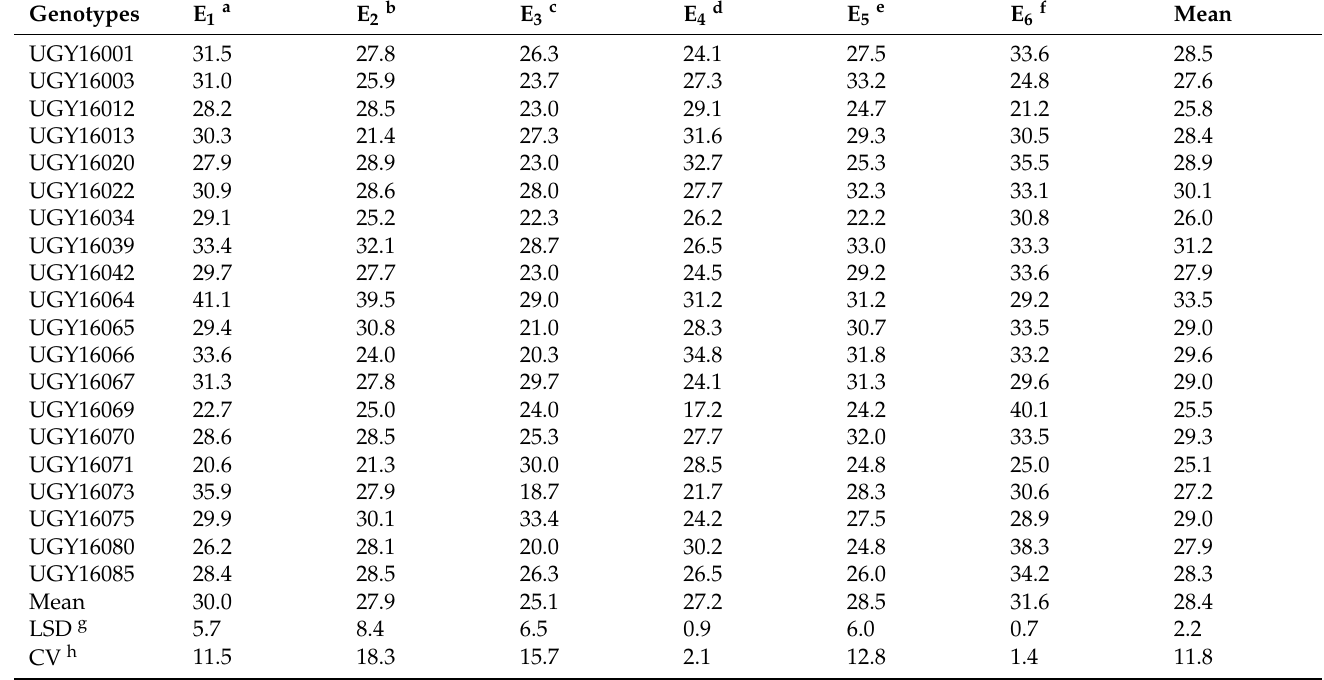
Table 8. Mean dry matter content of 20 yam genotypes evaluated in six environments within Uganda.